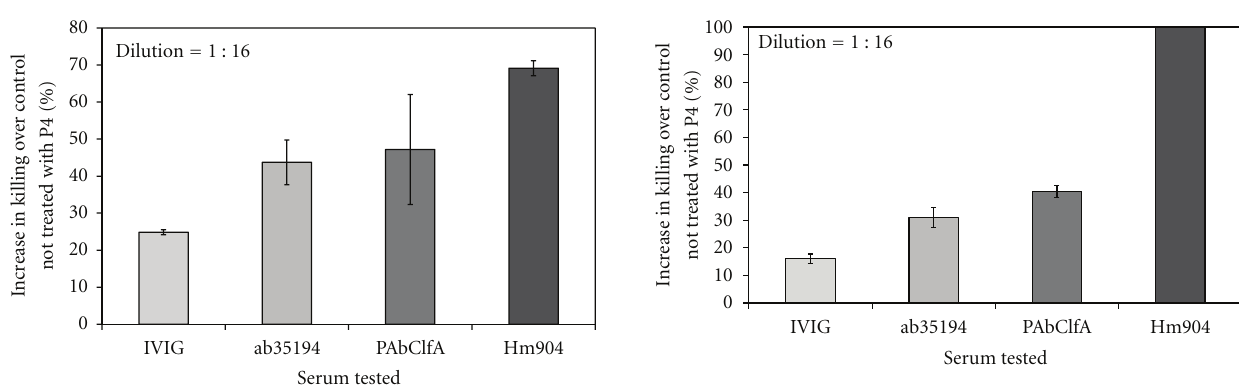
Figure 2: P4-mediated enhancement of OPK of S. aureus strainN with fresh PMNs isolated from human blood. In vitro opsonophagocytosis killing assay was performed with human peri- pheral blood PMN’s. Addition of P4 increased the opsonophago- cytic killing of S. aureus strainN in the presence of strain-speci- fic antibodies. Maximum enhancement ( ≥ 100%) was seen with HM904 over control that had all OPKA components except P4 ( P < 0 . 05). Antibodies used in this in vitro assay: Gamunex (IVIG), a pooled human serum having reactivity with a wide range of pathogens including S. aureus ; ab35194, rabbit polyclonal dir- ected towards the soluble and structural antigens of the S. aureus ; PAbClfA, rabbit polyclonal IgG directed towards the clumping factor A, ClfA of S. aureus , and HM904, humanized mouse mono- clonal anti-ClfA IgG.